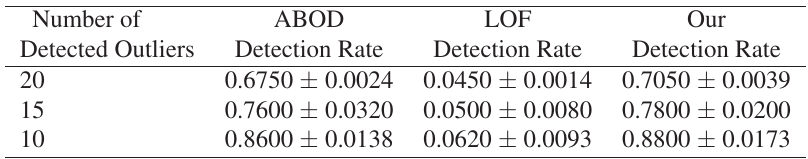
Table 2. The detection rate of each